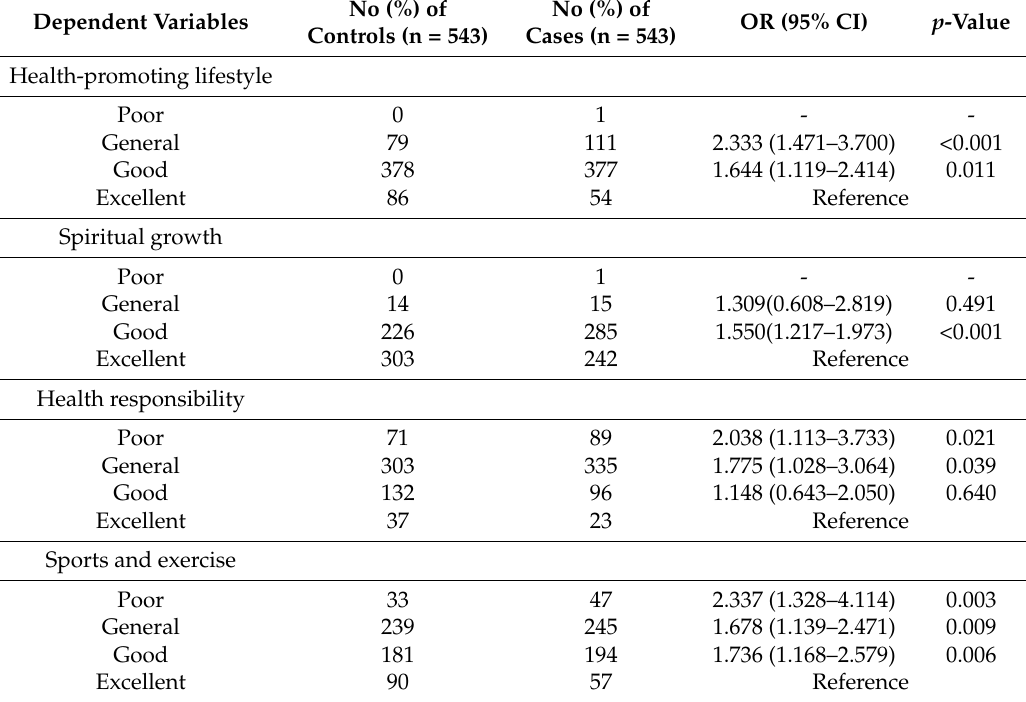
Table 4. Odd ratios and 95% confidence intervals for college students developing SHS group associated with the health-promoting lifestyle behaviors compared with the health group (OR =